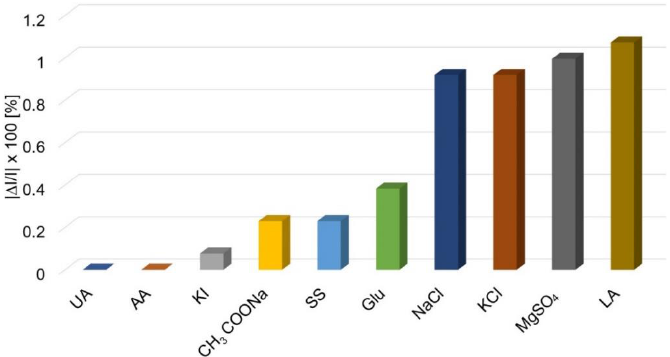
Figure 23. Average percentage errors for UA optical detection using TAmPP-PtNPs complex, introduced by different interferences. The complex TAmPP-PtNPs offers the best and highly stable response for UA in the introducing average percentage errors below 1.05%.